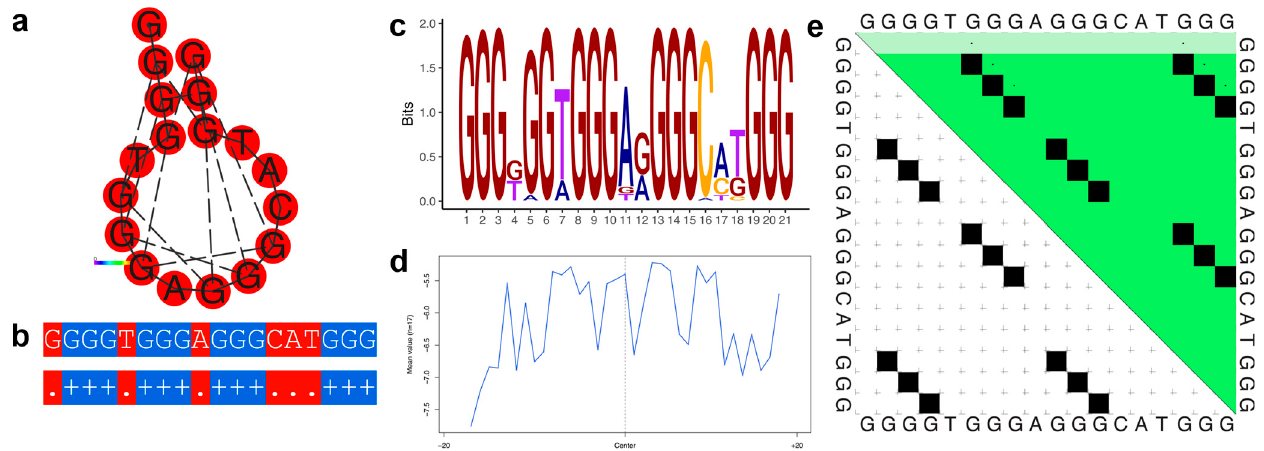
Figure 5. Thermodynamic properties for Family 75. ( a ) Centroid secondary structure with a minimum free energy of -22.82 kcal/mol using the consensus sequence of the family. ( b ) Dot-bracket notation showing the secondary structure. ( c ) Sequence logo representing the per base information content. ( d ) Electrostatic potential generated from all the sequences of the family using 10 flanking bases on either side of the identified G4. ( e ) Dot plot showing the substructures with the highest probabilities.